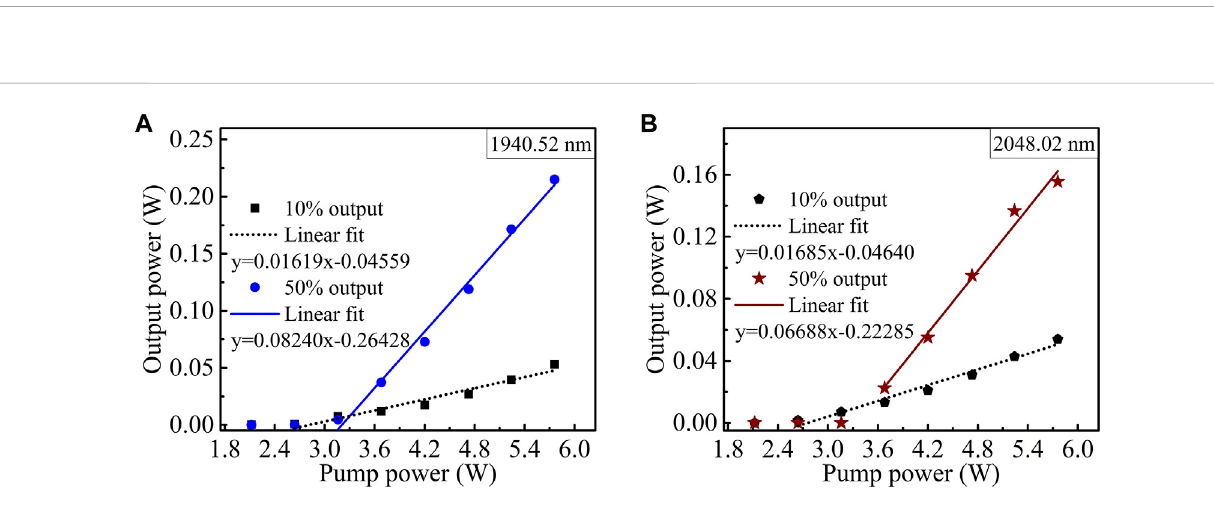
Figure 5A. Maximum output power of 215.12 mW was obtained by using an output coupling ratio of 50% and a pump power of 5.76 W. The minimum threshold power was 2.82 W when using an output coupling ratio of 10%. Similarly, when the central wavelength of the single-